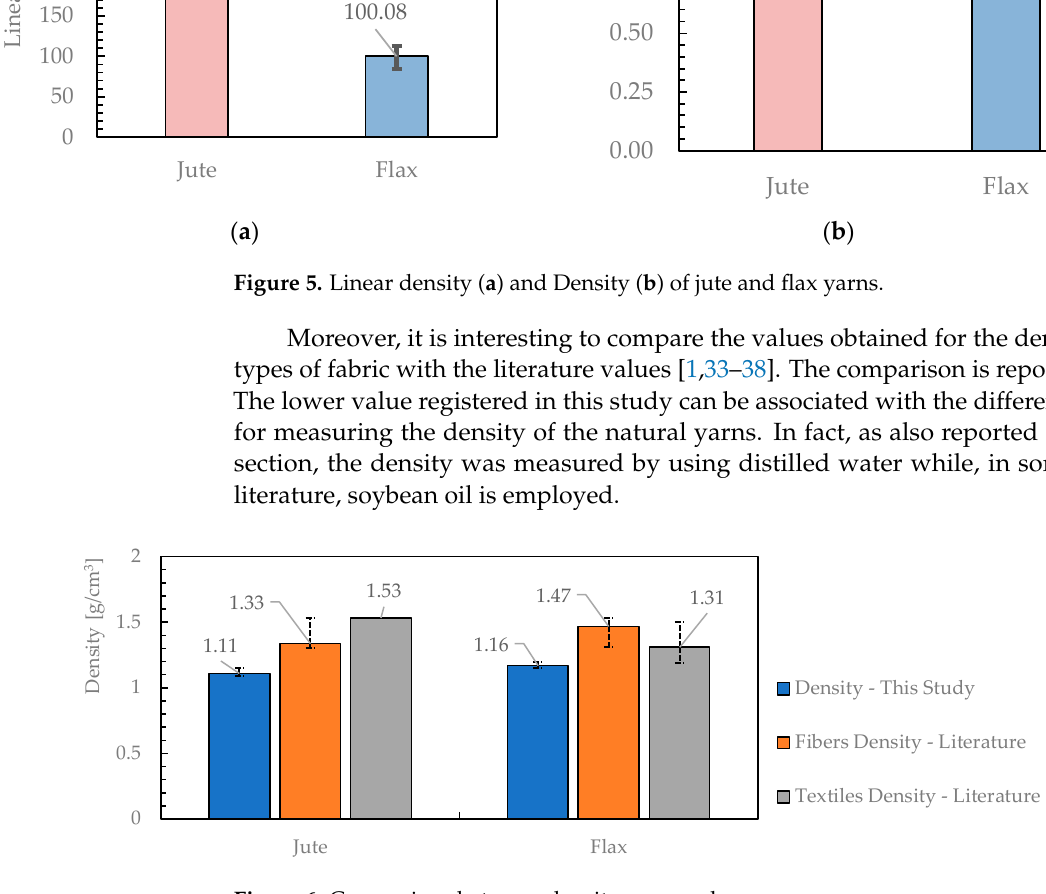
Figure 6. Comparison between density mean values.